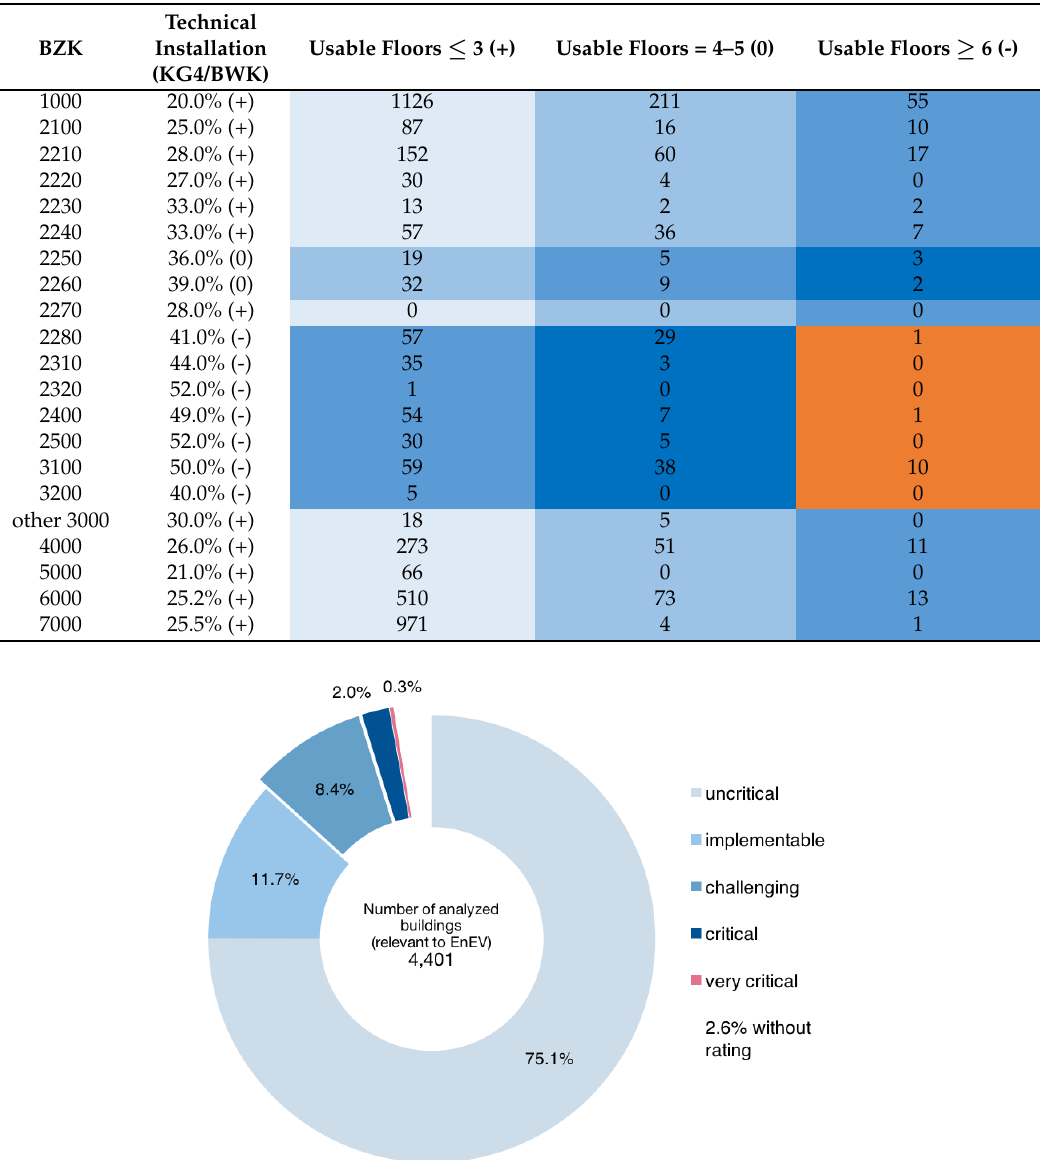
Figure 8. Risk assessment with the criteria of degree of technical installation (KG4/BWK) and usable (above ground) floors using the example of the FDH of Bavaria [10].